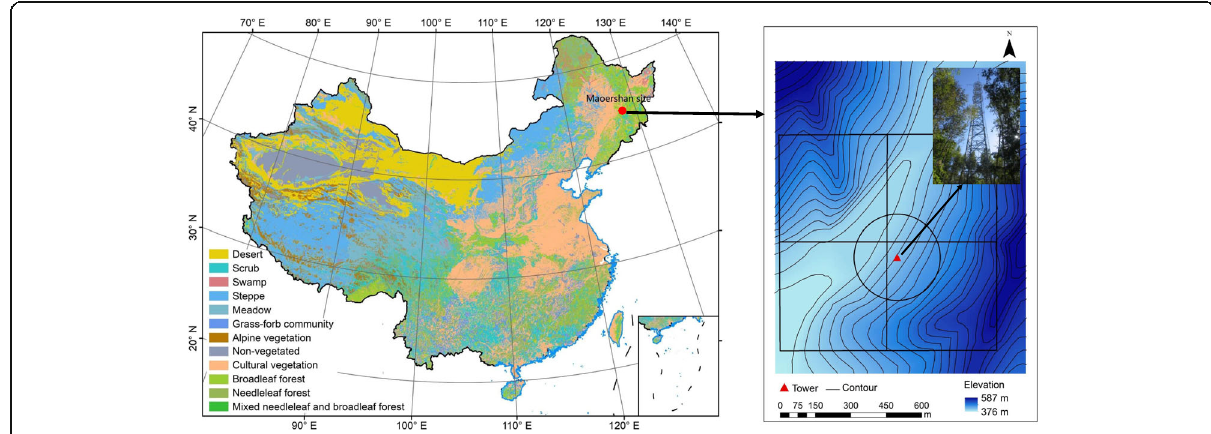
Fig. 1 A map of study area with the location and photo image of eddy-flux tower. The four squares and the circle represent the four pixels of MODIS and the reflective footprint of the radiometers installed on the tower (90% of signal), respectively. The vegetation map of China